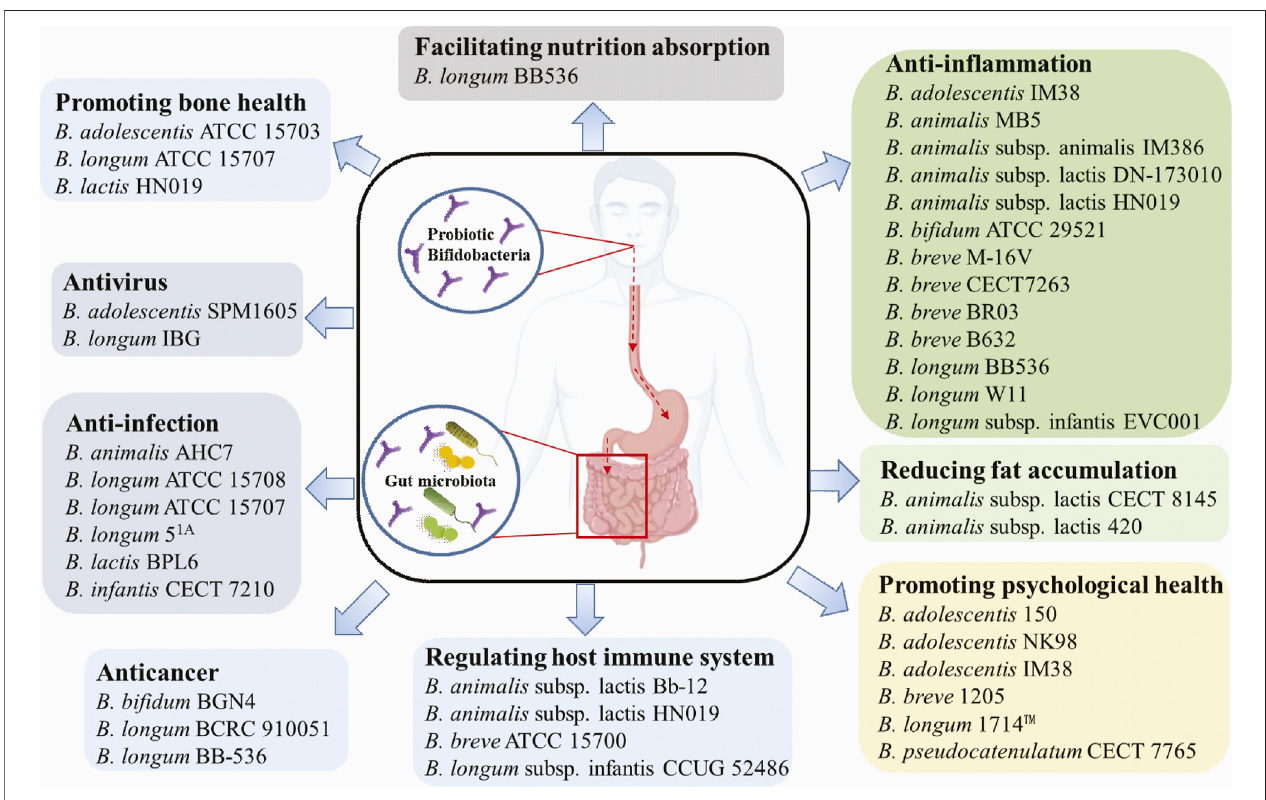
FIGURE 1 | Bene fi cial effects of common probiotic Bi fi dobacterium